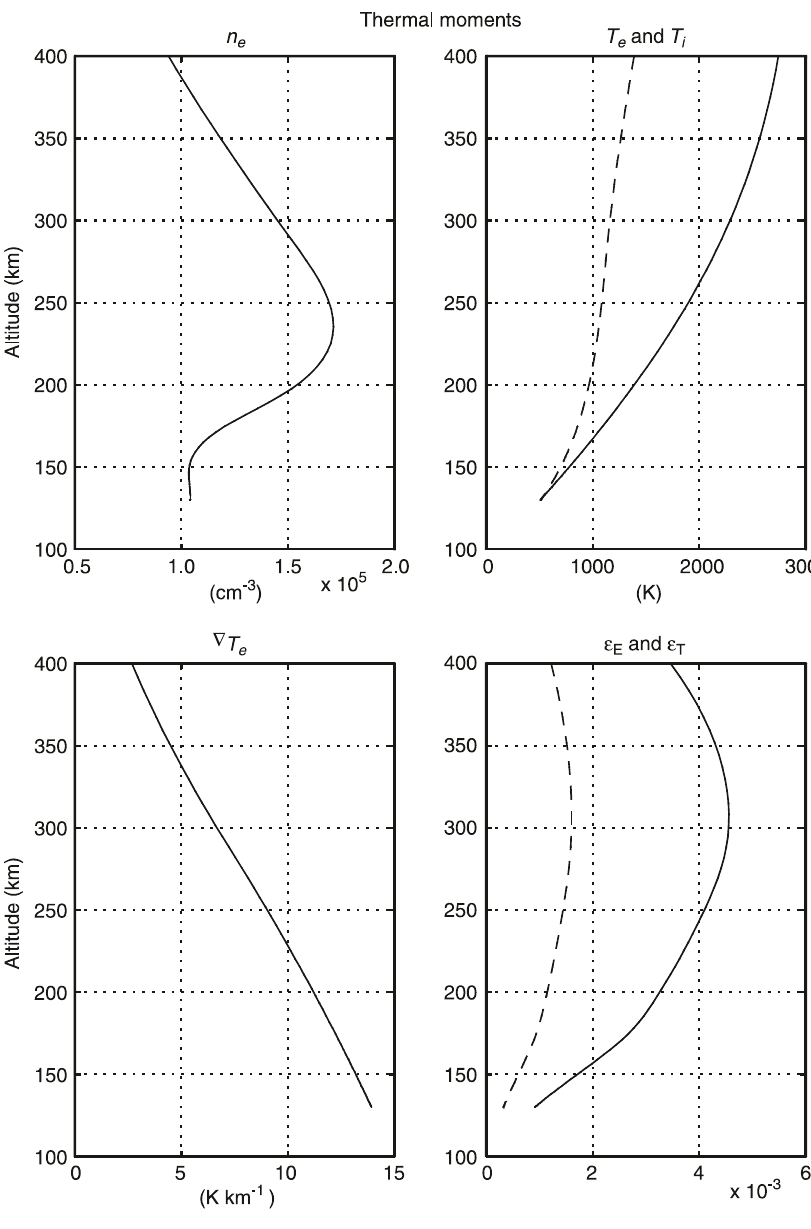
Fig. 10. The parameters for the ambient part of the distribution function, i.e. the electron density n e , the electron and ion temperatures T e and T i ( solid line and dashed line , respectively), the gradient of temperature r T e and the two Knudsen numbers (cid:15) T ( solid line ) and (cid:15) E ( dashed